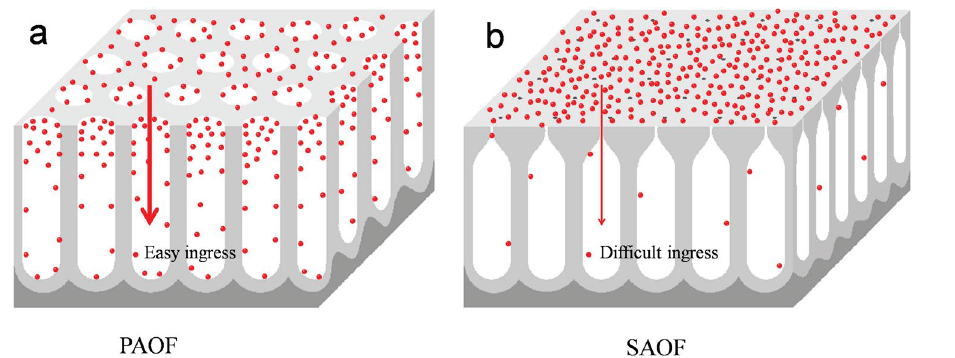
Figure 6. The mechnism of the anti-corrosion of SAOF and